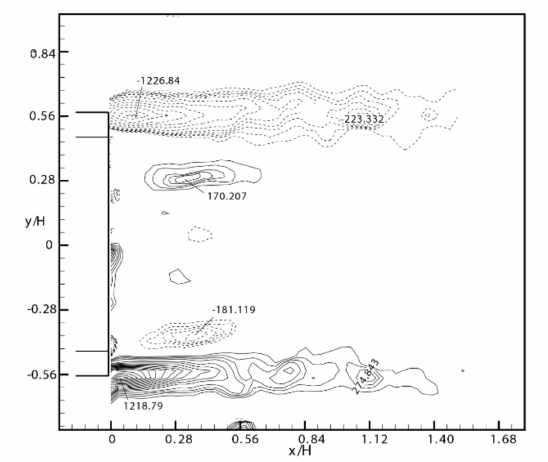
Figure 28. Iso-contours of averaged stream- wise vorticity, ω z in x–y plane at z/H = − 0.34. Minimum and incremental values of vorticity are ω z,min = − 103.715 s − 1 , 119.761 s − 1 , and ∆ ω z = 58.150 s − 1 ,